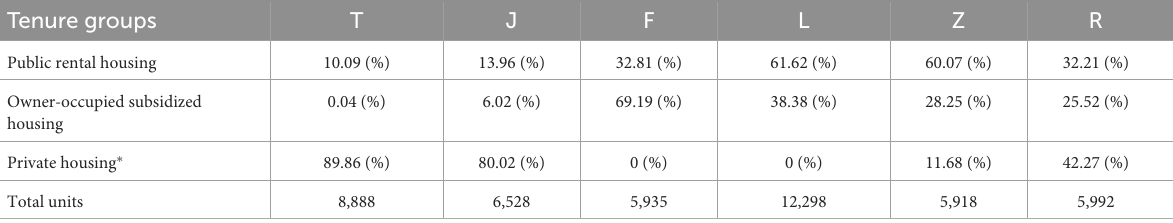
TABLE 1 Distribution of housing tenure types of the selected estates. Tenure